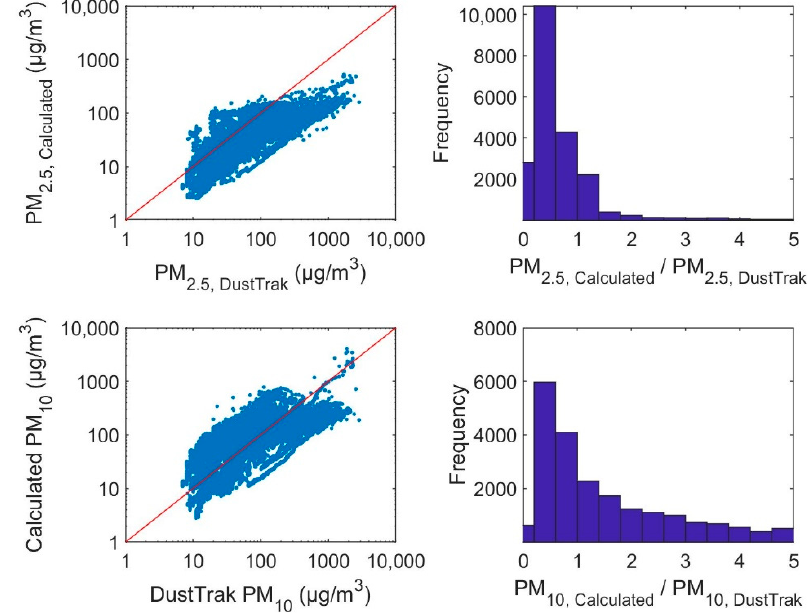
Figure 4. Comparison between the PM 2.5 and PM 10 concentrations measured with DustTrak and those calculated using the measured particle number size distributions, assuming spherical particles of unit density.